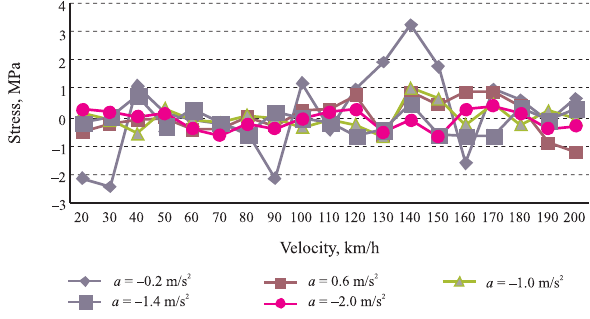
Fig. 9. Max stresses of the plate with different velocities and fixed